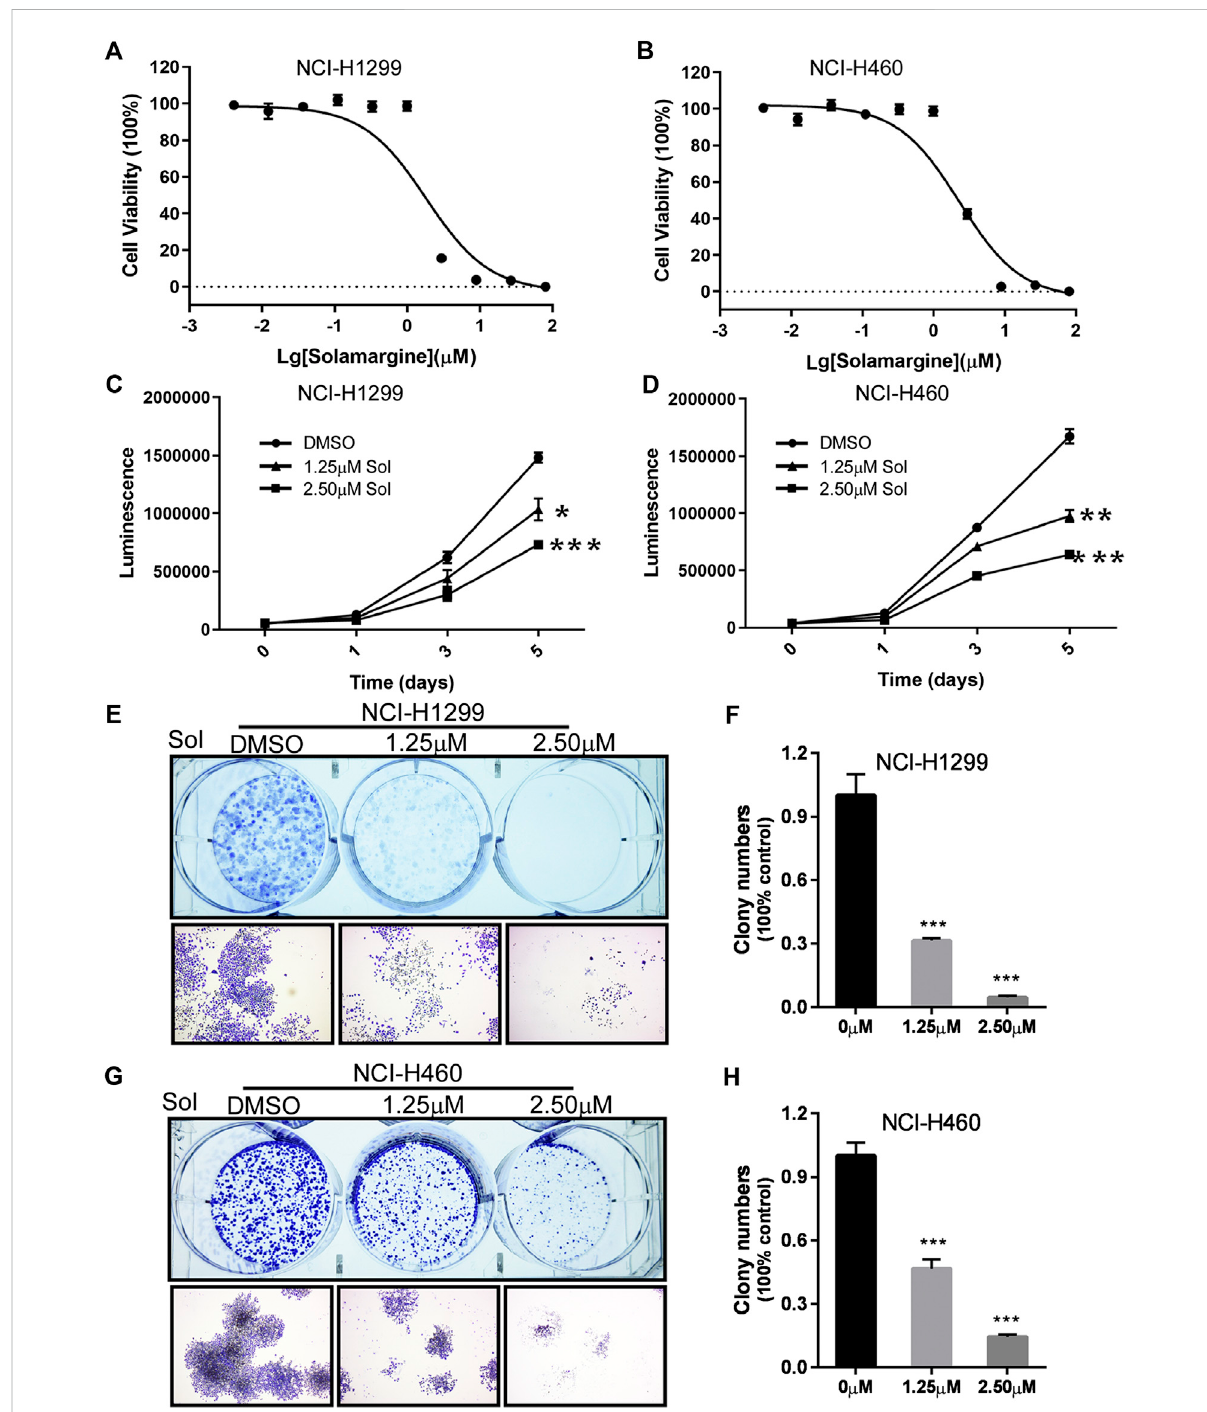
FIGURE 2 Solamargine signi fi cantly inhibited cell growth in NCI-H1299 and NCI-H460 cells. (A,B) The dose-response curves and IC 50 values of Solamargine in NCI-H1299 and NCI-H460, respectively. N = 3. (C,D) Cell proliferation suppression in NCI-H1299 and NCI-H460 with the treatment of Solamargine at the concentration of 1.25 and 2.5 μ M for 5 days. N = 3. (E – H) Solamargine inhibited the colony formation in NCI-H1299 and NCI- H460 cells at the concentration of 1.25 and 2.50 μ M for 7 days. Cells were stained with crystal violet solution at the endpoint. N = 3. One-way ANOVA was used for statistical tests. * p <